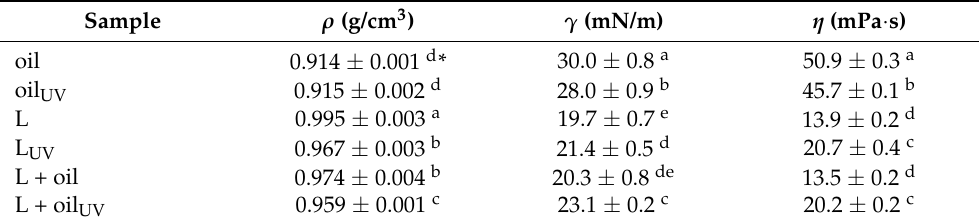
Table 2. Density ( ρ ), surface tension ( γ ), and viscosity ( η ) of Rosa canina seed oil, empty, and oil-loaded liposomes (non-treated and